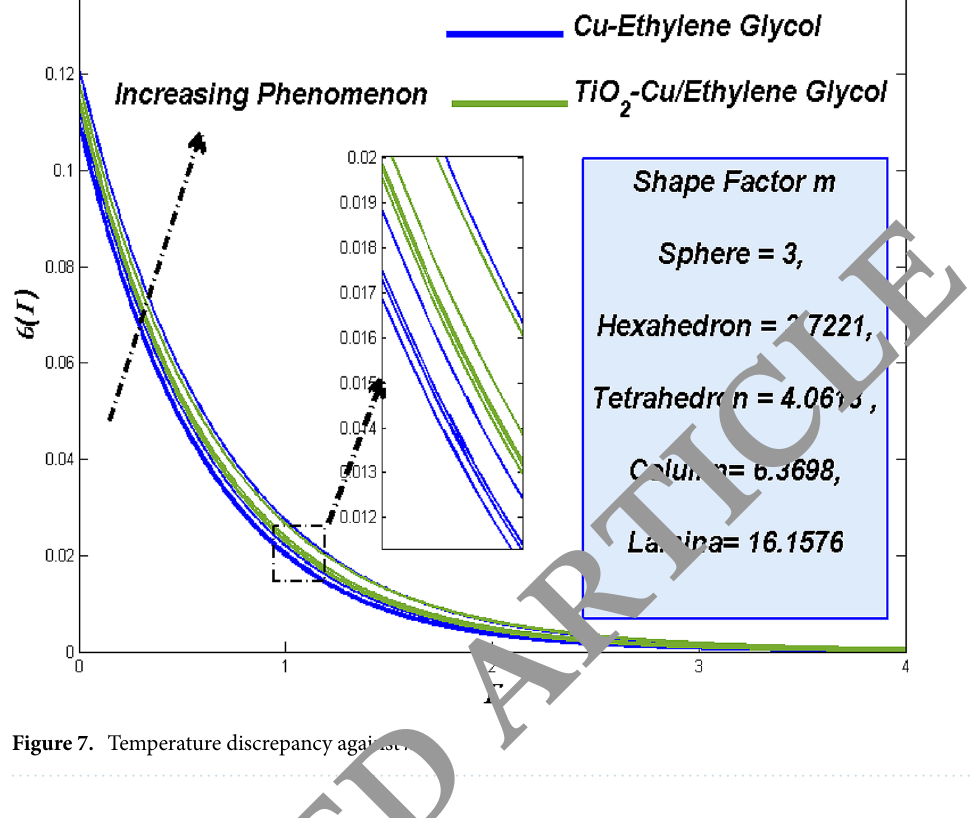
Figure 7. Temperature discrepancy against m .